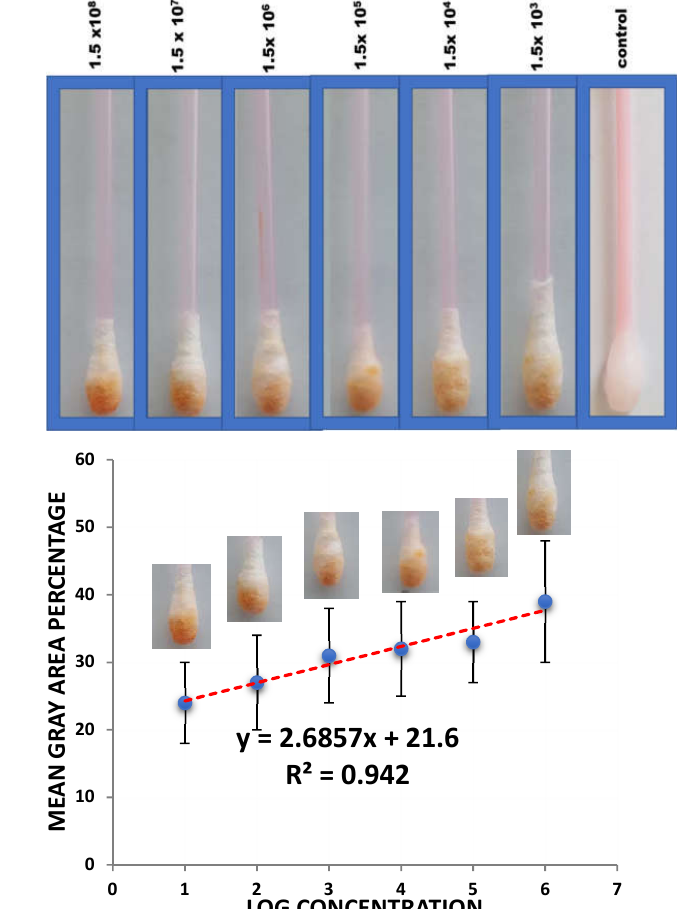
Figure 2. ( A ) Colorimetric detection of different SARS-CoV-2 concentrations (10 3 –10 8 pfu/mL). ( B ) Quantitative load of the SARS-CoV-2 collected by the swab and the calibration curves of the different SARS-CoV-2 concentrations using the sandwich colorimetric immunoassay; a plot of the colored area percentage versus SARS-CoV-2 concentrations.